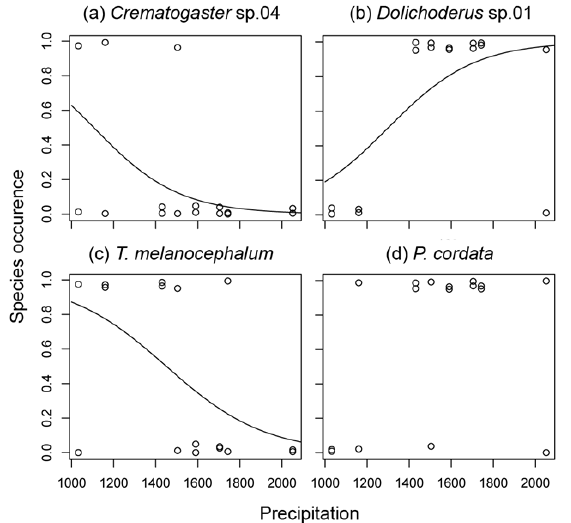
Figure 3. Logit regression of ant species with precipitation. (a) Crematogaster sp.04 (df=1, Chi-square=3.84, P=0.04), (b) Dolichoderus sp.01 (df=1, Chi-square=5.06, P=0.02), (c) Tapinoma melanochephalum (df=1, Chi-square=4.59, P=0.03) and (d) Philidris cordata (df=1, Chi-square=2.41,